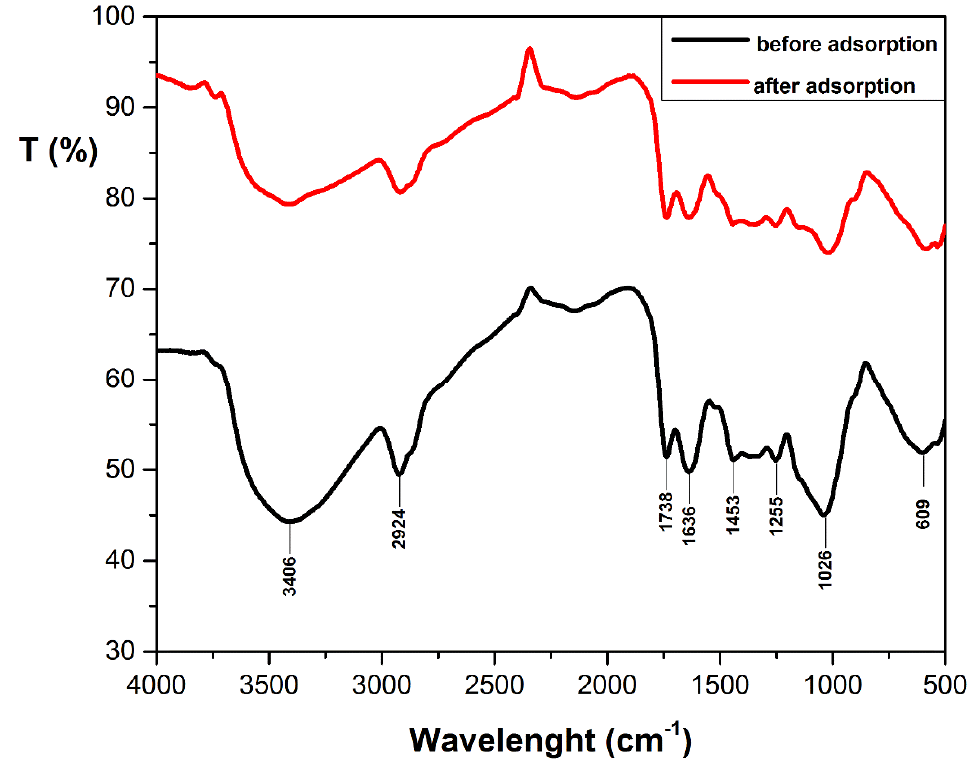
Figure 2. FT-IR spectrum of DBPH powder.